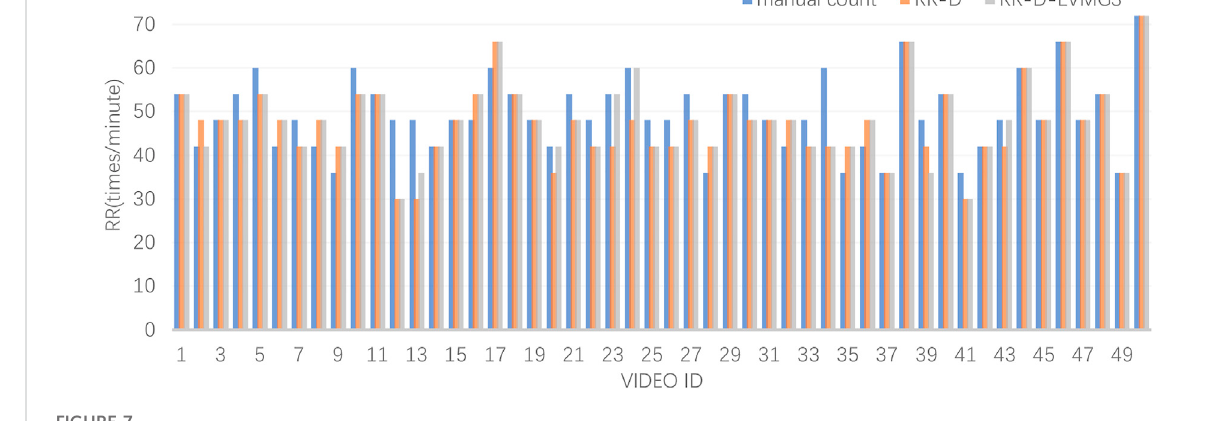
FIGURE 7 RR estimation result.